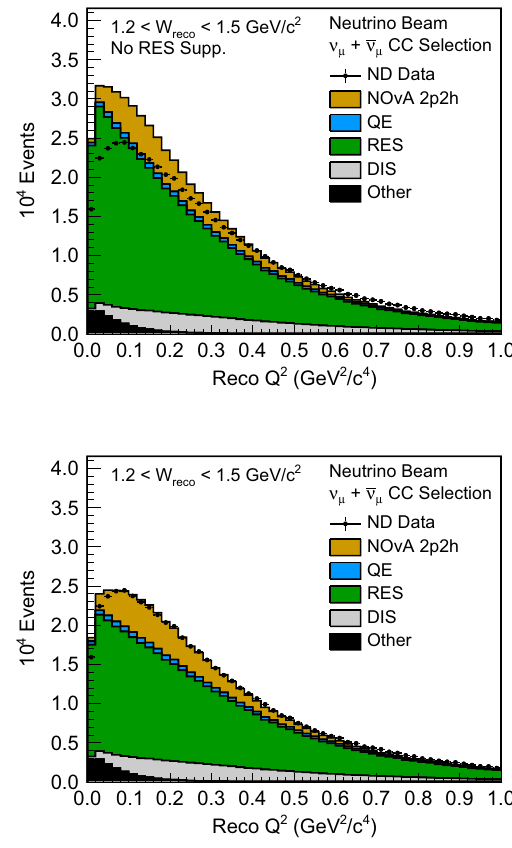
Fig. 2 Reconstructed Q 2 distributions in the reconstructed W range of 1.2 to 1 . 5 GeV/ c 2 , where RES events dominate. Data are shown with statisticalerrorbars,whilesimulationisshownashistogramsstackedby interactiontype.Allcrosssectionadjustmentsdescribedinthispaperare